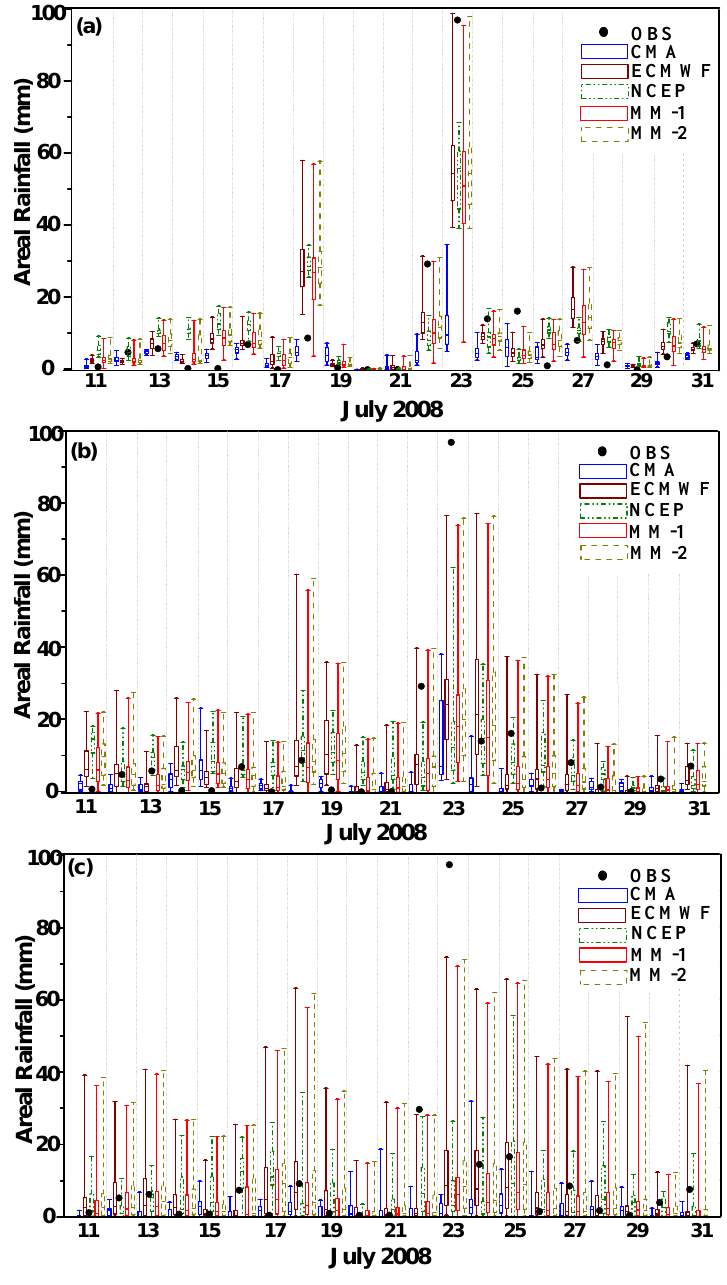
Fig. 4. Percentile area-averaged-precipitation of CMA, NCEP, ECMWF, MM-1 and MM-2 over Dapoling-Wangjiaba catchment for lead time of (a) 1-day, (b) 5-day, and (c) 10-day during the study period. The five short lines in every box-and-whisker plot indicate the 5-th, 25-th, 50-th, 75-th, and 99-th percentile precipitation, respectively.